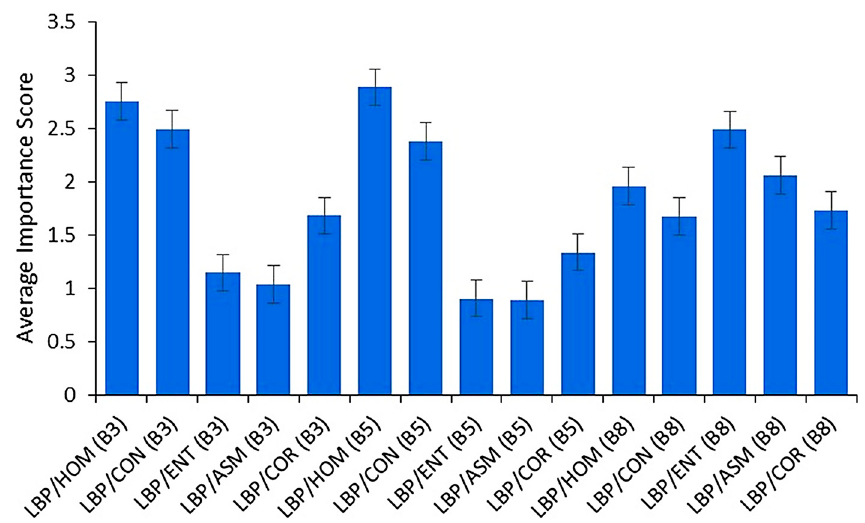
Figure 4. The relative importance of the LBP/GLCM model in discriminating between vegetated gaps, shaded gaps, and tree crowns by random forest. Error bars are 95% con fi dence intervals.